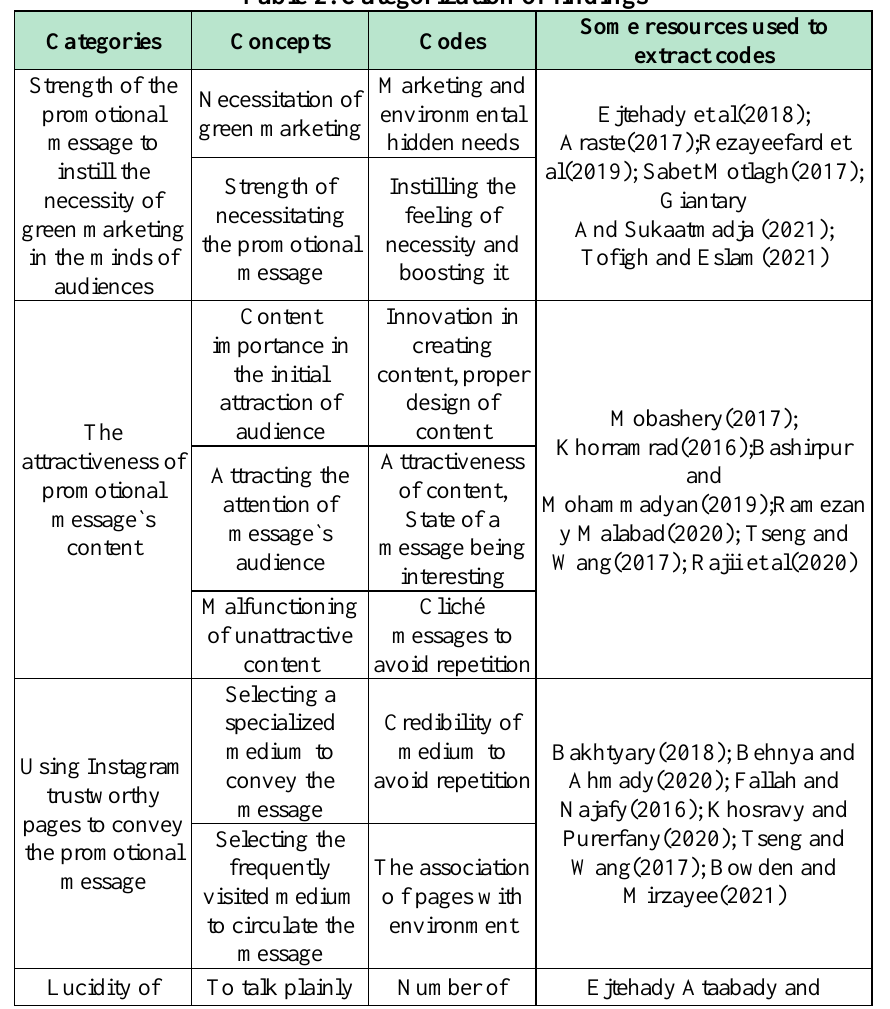
Table 2. Categorization of